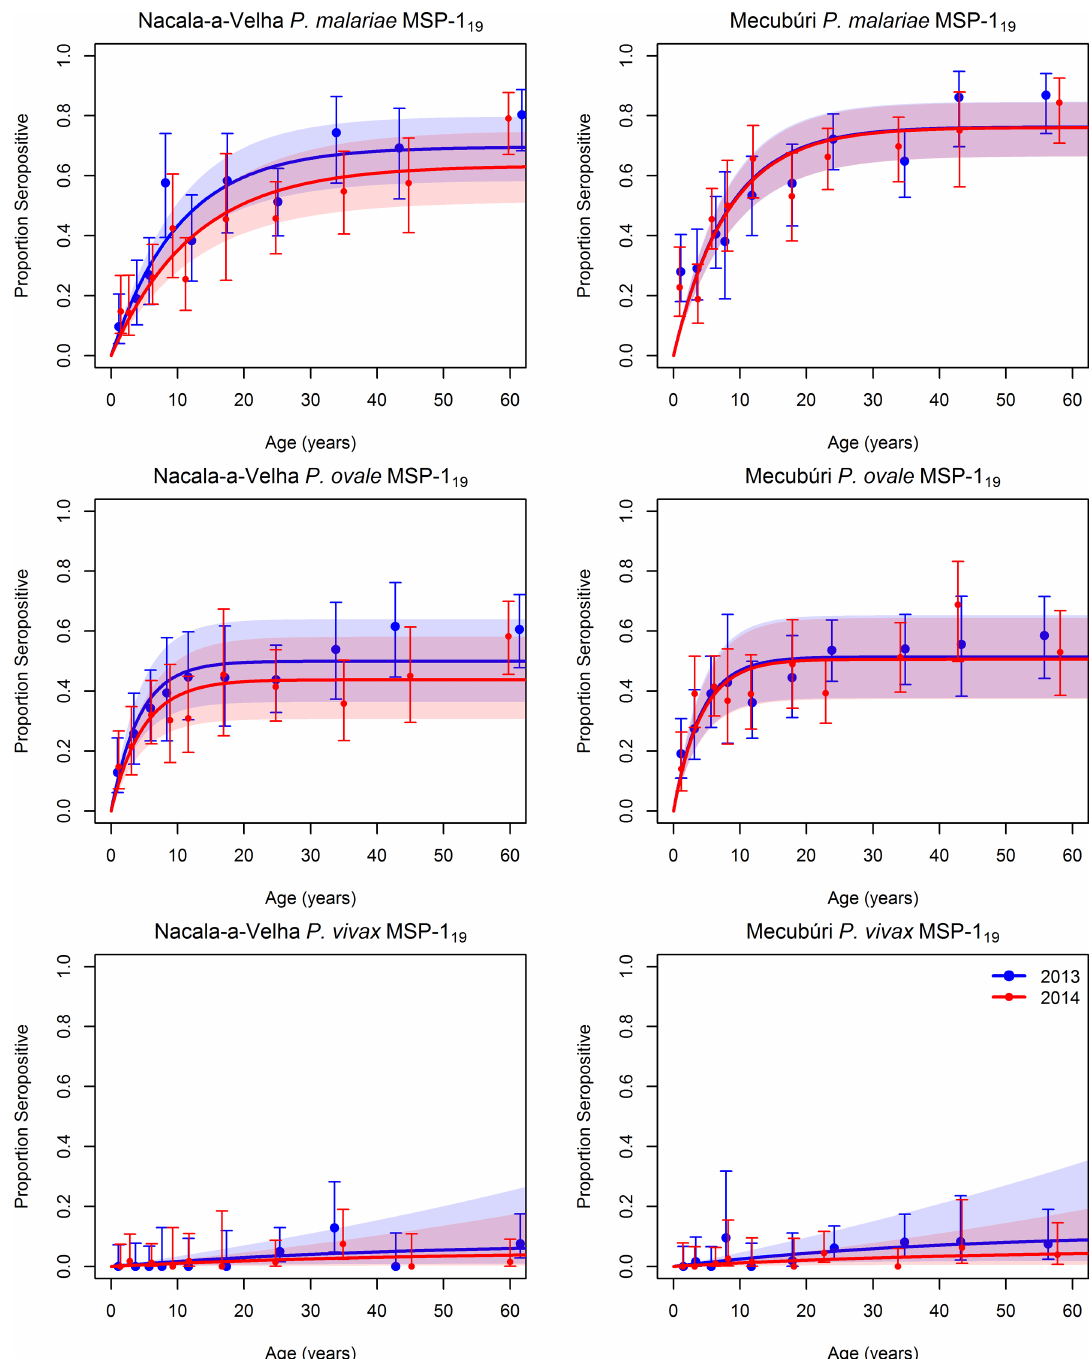
Fig 2. Seropositivity by age for antibodies to P . ovale , P . malaria , and P . vivax MSP-1 19 antigens in community members sampled during household surveys in Nacala-a-Velha and Mecubu´ri Districts, Northern Mozambique, 2013–2014. Points represent estimates and 95% confidence intervals for seropositivity for each age category, curves represent the fit of a catalytic conversion model, and shaded areas represent the 95% confidence intervals of model fit: blue for 2013, red for 2014, and purple for the overlap.